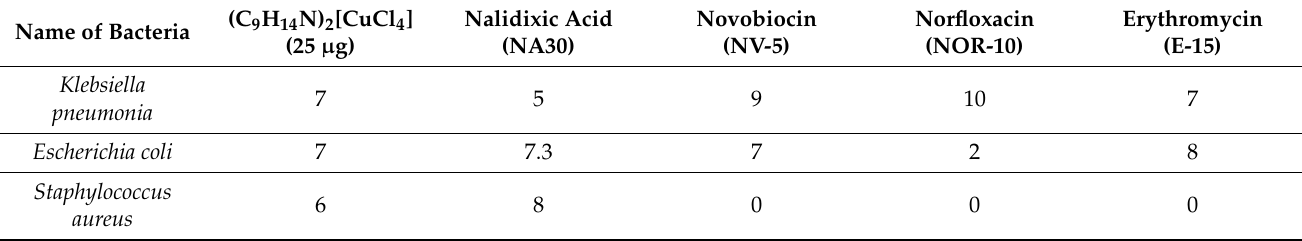
Table 7. Diameters of inhibition zones produced by (C 9 H 14 N) 2 [CuCl 4 ], Nalidixic acid (NA30), Novobiocin (NV-5), Norfloxacin (NOR-10), and Erythromycin